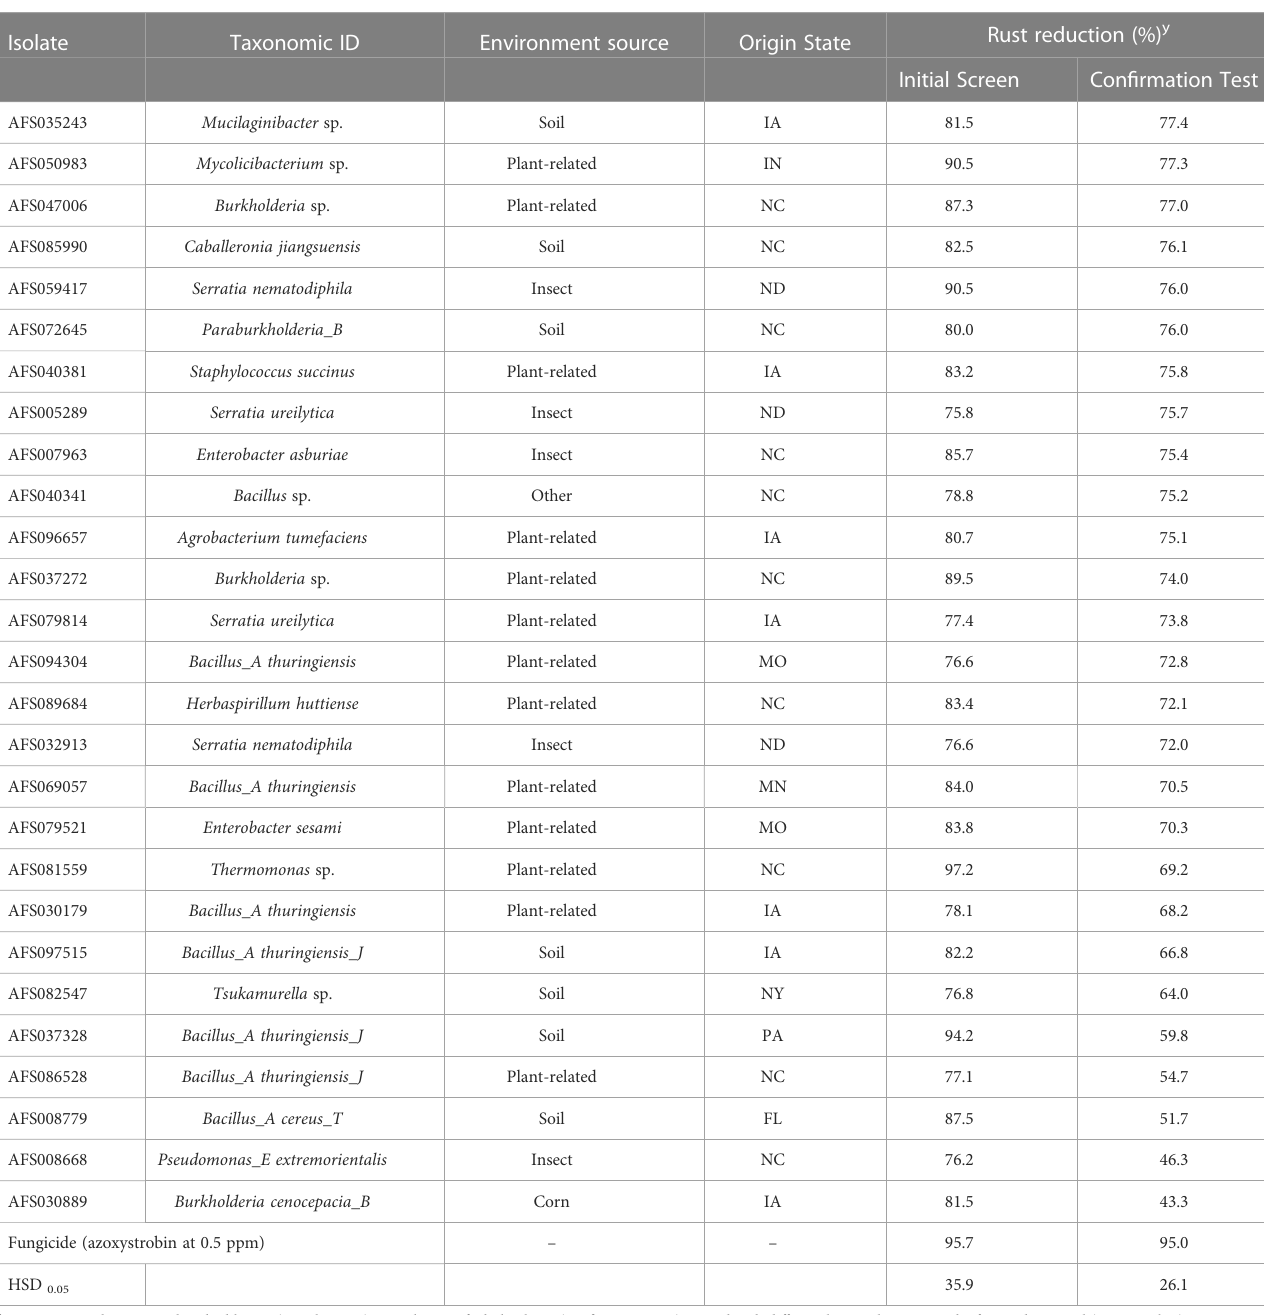
(Table 2) and controls as described for the greenhouse study. Treatments were reapplied 14 days after the fi rst application. At NFREC-Quincy, plants were inoculated 1, 4 and 8 day(s) after the fi rst treatment application with a suspension (1 × 10 5 rust urediniospores/mL of city tap water) of a mixture of P. pachyrhizi urediniospores earlier described; in addition to arti fi cial inoculation, natural infection was also present in the fi eld. At GCREC-Fairhope, bacterial strains were evaluated under natural infection. Plots were arranged in a randomized complete block design with